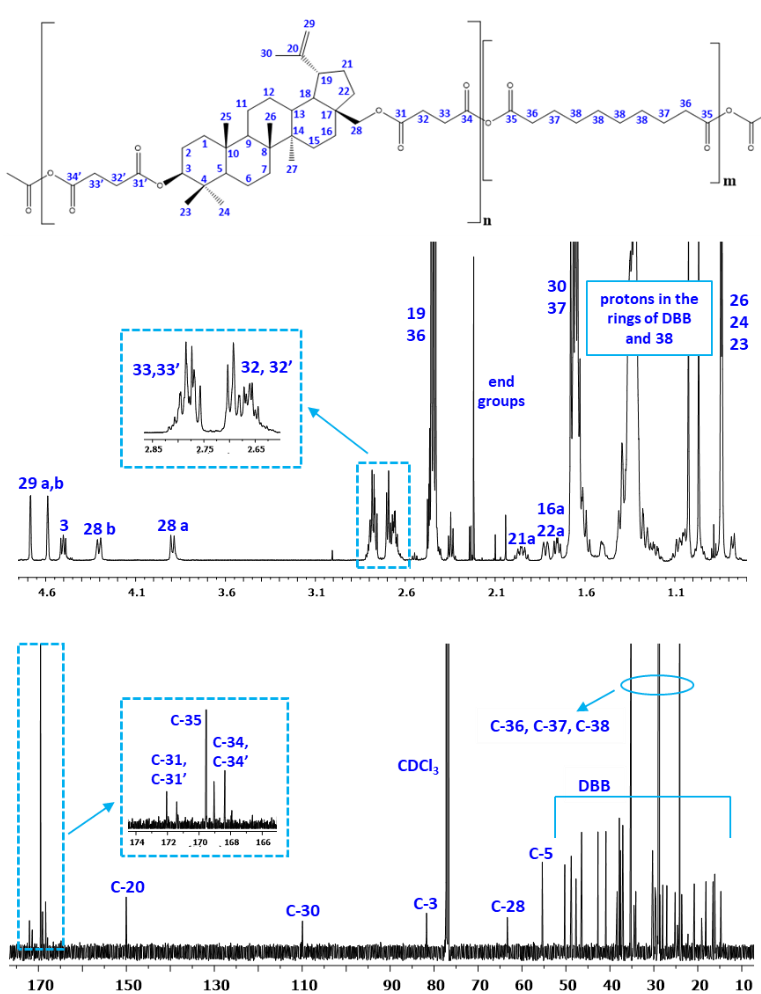
Figure 2. 1 H NMR and 13 C NMR spectra of polyDBB_SEB.